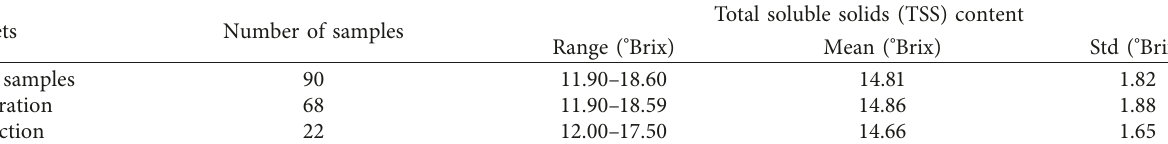
Table 1: Reference measurement of TSS ( ° Brix) of total samples used.